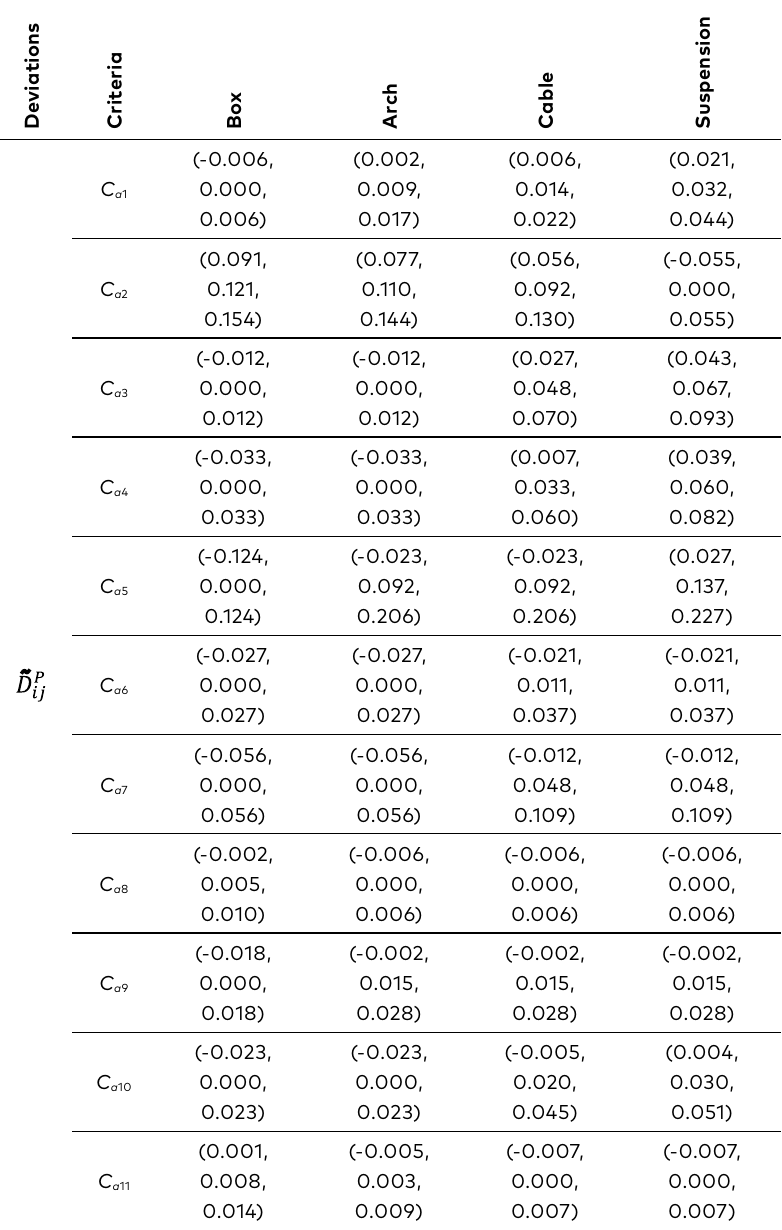
Table 8. The values